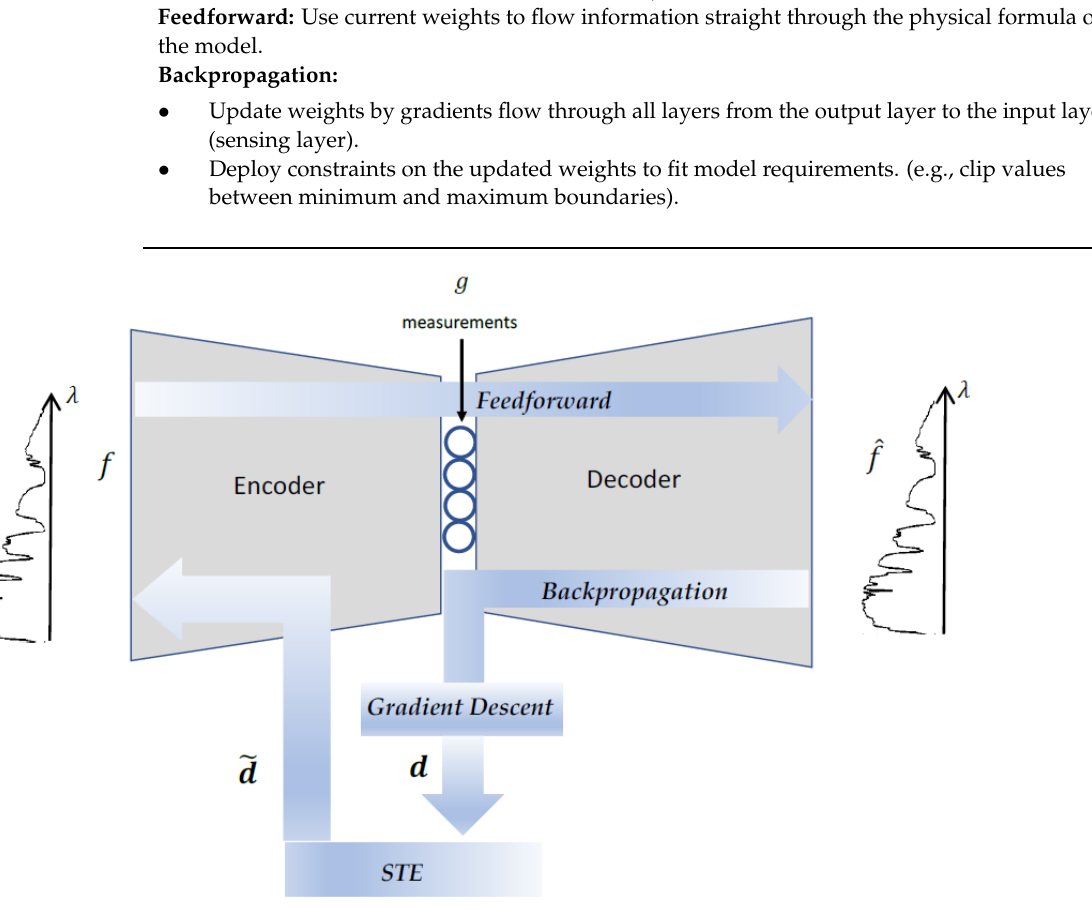
Figure 3. Illustration of the STE algorithm for the physical constraints and limitations that must be imposed on the gaps of the etalons. At the feedforward phase, the input signal flows from the encoder outputs 𝑔 (the measurements) to the decoder and is reconstructed at the output of the decoder. At the backpropagation phase, gradients flow backward from the output layer of the decoder through the bottleneck and update the etalons depths 𝑑 . Then, a set of constraints and limitations are imposed on 𝑑 by the STE, and 𝑑̃ , the constrained etalons depths, are assigned as the new weights of the sensing layer.